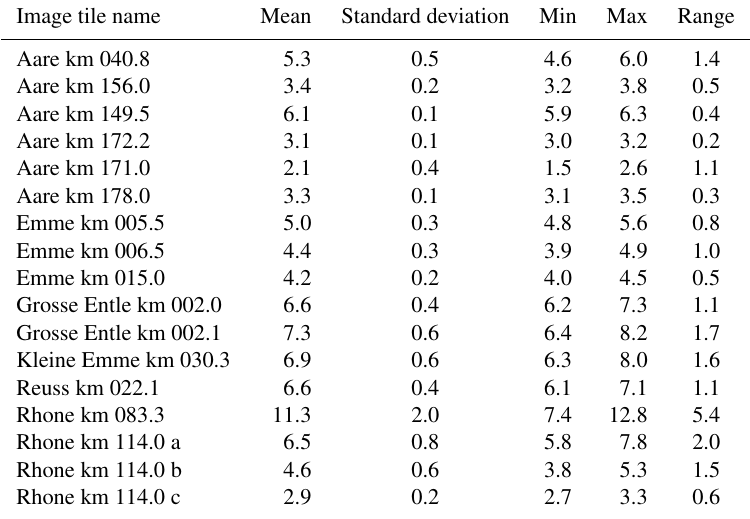
Table C1. Statistics of the mean diameter d m [cm] from three to five human annotations for 17 randomly selected image tiles.